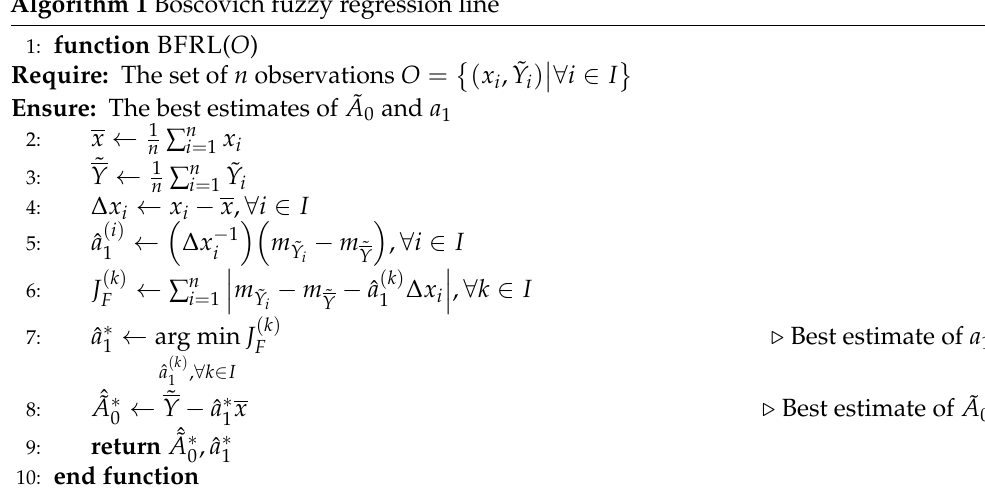
Algorithm 1 Boscovich fuzzy regression